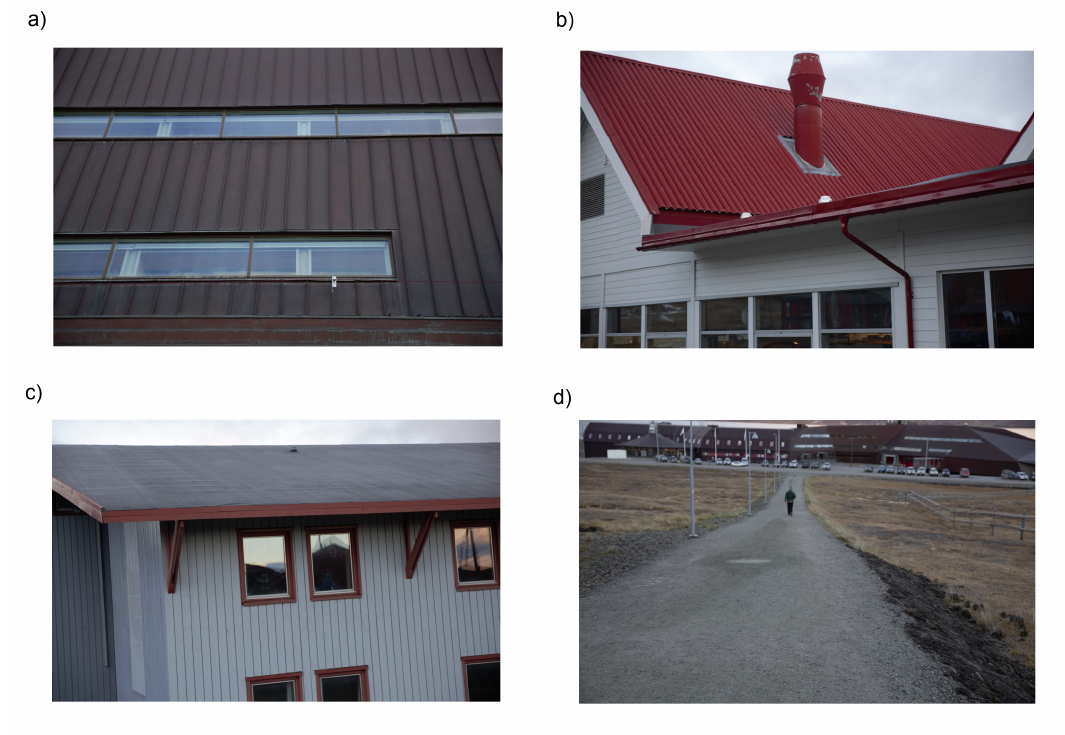
Figure 2. Examples for roof and road types considered in Lu et al. [54] for Longyearbyen (object ID in ()): ( a ) pitched metal roof, dark paint (#1); ( b ) pitched metal roof, red paint (#5); ( c ) pitched with roofing felt (#15); and ( d ) gravel footpath